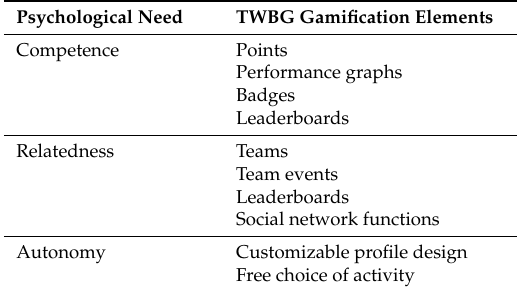
Table 1. Gamification elements in ‘The Wellbeing Game’ (TWBG) according to the Self-Determination Theory